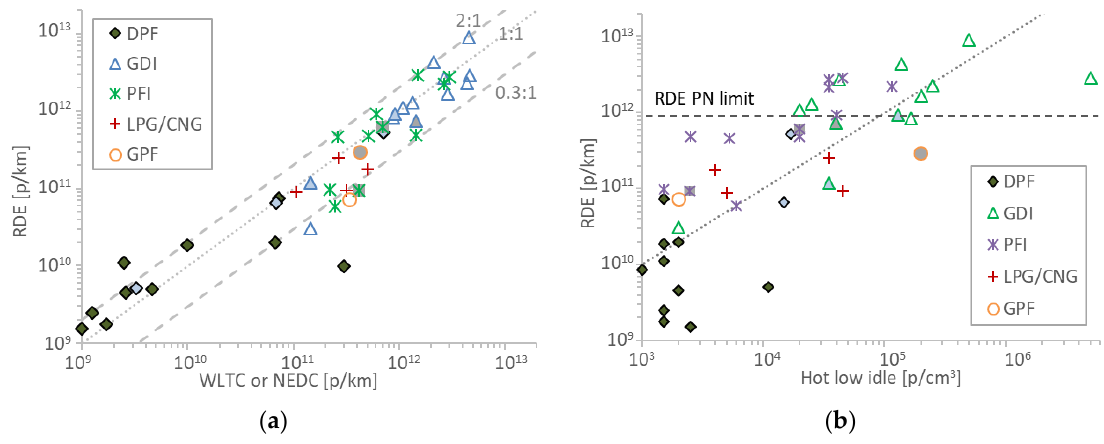
Figure 5. Scatter plots of RDE tests vs. : ( a ) cold start WLTC or NEDC; ( b ) hot idle concentrations. Hybrids have grey background. Vehicles with start and stop have light blue background. CNG = Compressed Natural Gas; DPF = Diesel Particulate Filter; GDI = Gasoline Direct injection; GPF = Gasoline Particulate Filter; LPG = Liquefied Petroleum Gas; PFI = Port Fuel Injection; PTI = Periodical Technical Inspection.